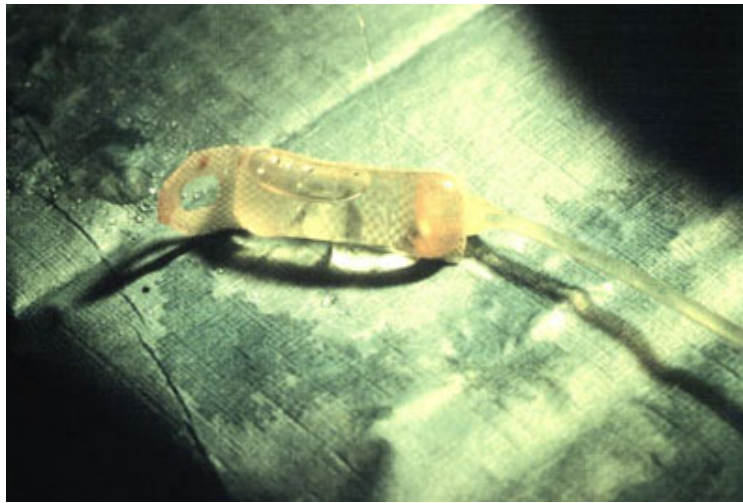
FIGURE 6 . Pinhole leak from occlusive cuff of artificial urinary sphincter removed at surgical